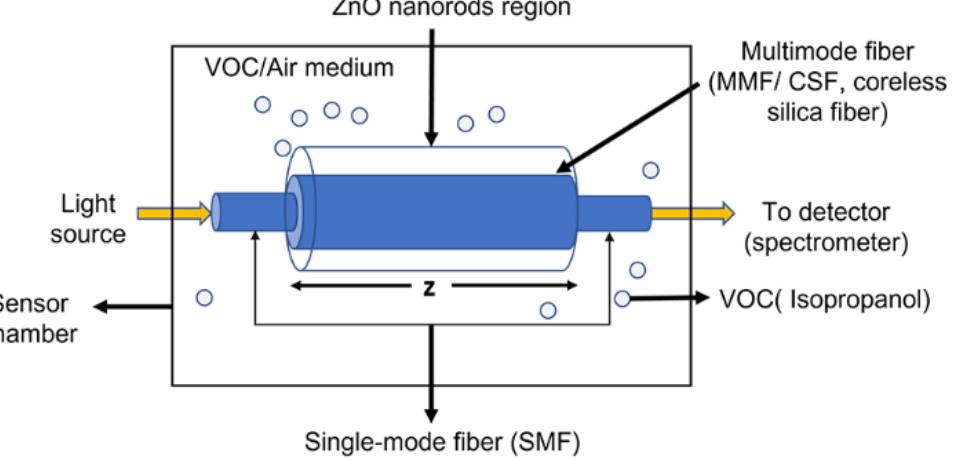
Figure 1. Schematic illustration of the designed sensor with ZnO nanorods coated on the CSF in- serted between two